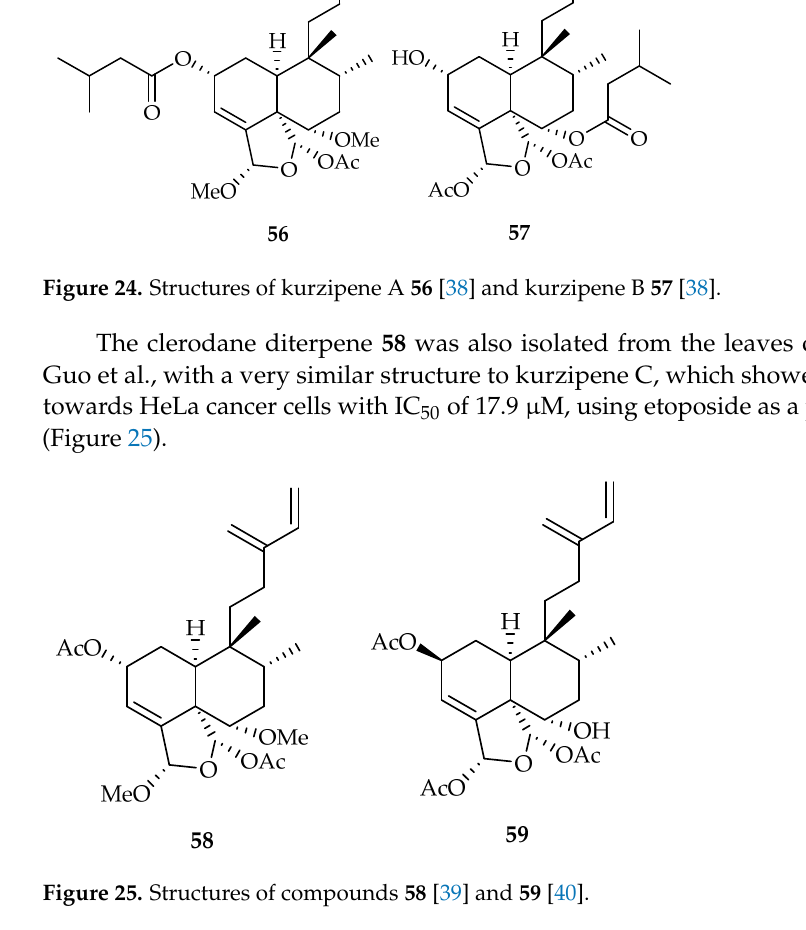
Figure 23. Structures of caseakurzin B 54 [37] and caseakurzin J 55 [37]. Further, six new clerodane diterpenoids, designated as kurzipenes A–F, were isolated by methanolic extraction and subsequent partitioning with EtOAc from the leaves of Casearia kurzii [38]. Their structures were elucidated on the basis of NMR spectroscopic data analysis, while the absolute configurations were assigned by the time-dependent density functional theory (TDDFT) electronic circular dichroism (ECD) calculations. The cytotoxic activities of the new compounds were evaluated against A549, HeLa, and HepG2 cell lines. Kurzipenes D–F were weakly effective (IC 50 values > 60 μM), while kurzipene A 56 and kurzipene B 57 showed promising activities, with IC 50 values ranging from 5.3 to 19.0 μM, compared to the positive control etoposide. Compound 57 , with an IC 50 value of 5.3 μM, was particularly cytotoxic against HeLa cells (Figure 24).